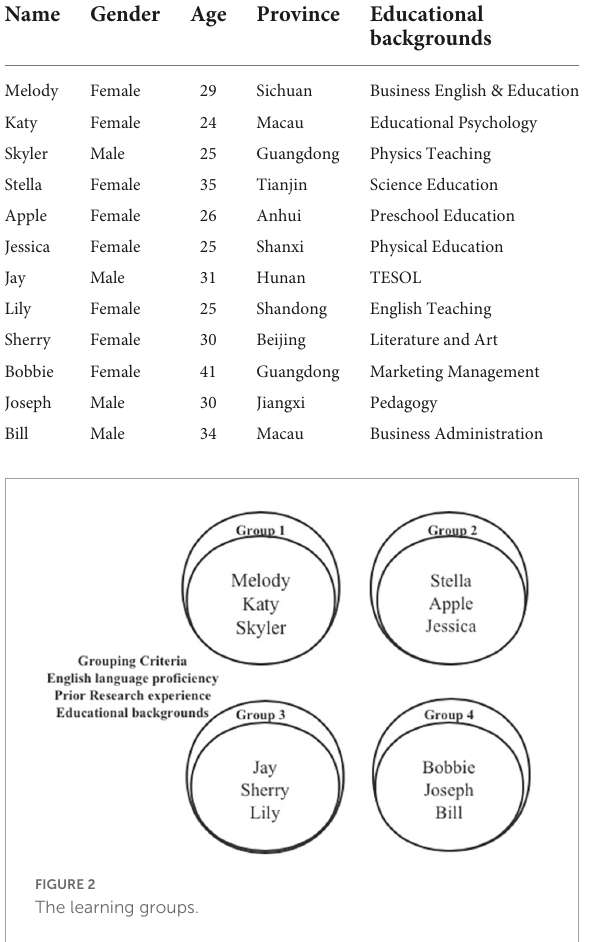
TABLE 2 Teacher’s question prompts for research outline